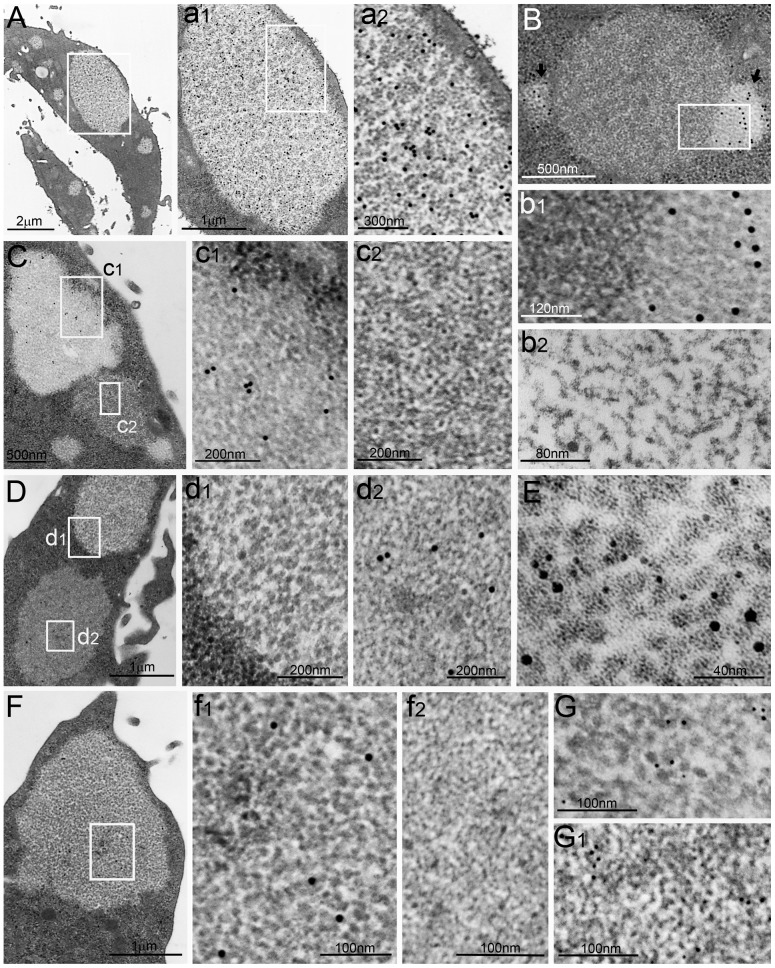
PaCSs and sequestosomes in HeLa cells.(A) Several PaCSs are scattered in the cytoplasm of two cells, the larger one (boxed) is enlarged in (a1) and further in (a2) to show particle accumulation in a clear cytosolic background and selective FK1 immunogold reactivity for polyubiquitinated proteins. (B) Two small PaCSs (arrows) adjacent to a large central sequestosome in a ribosome-rich cytosol; the boxed area is enlarged (b1) to show PaCS 20S proteasome reactivity (right) and non-reactivity of the sequestosome (left), characterized by amorphous to thinly granular material often forming short fibrils. The curved fibrils are better seen at higher magnification (b2) of a sequestosome with poorly contrasted amorphous interfibrillary material. (C) Three PaCSs surrounding a sequestosome; the larger PaCS enlarged in (c1) shows 19S proteasome immunoreactivity, which is missing in sequestosome (c2), whose thin granules are often aligned to form beaded fibrils. (D) PaCS (top) and sequestosome (bottom) in ribosome-rich cytoplasm, enlarged in (d1) and (d2), respectively, to show sequestosome p62 protein immunoreactivity and PaCS non-reactivity; ribosomes in the left lower corner of (d1). (E) High resolution micrograph of PaCS particles reactive for 20S proteasome (10 nm gold) and FK1 (5 nm gold) antibodies. Some particles were aligned end-on to form 40-nm-long cylinders. (F) Sparse glycogen immunoreactivity of a PaCS, enlarged (f1) to be compared with a glycogen-unreactive granular–fibrillary sequestosome (f2) of the same section. The anti-ubiquitin Z0498 antibody reacted with both PaCS (G) and sequestosome (G1).